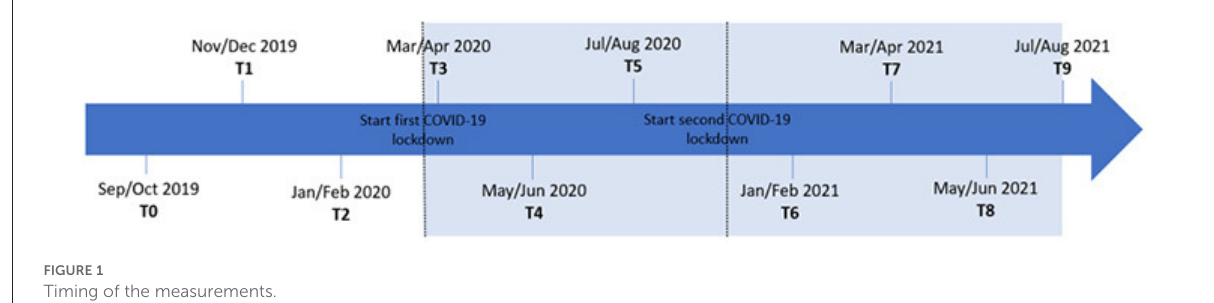
FIGURE1 Timing of the